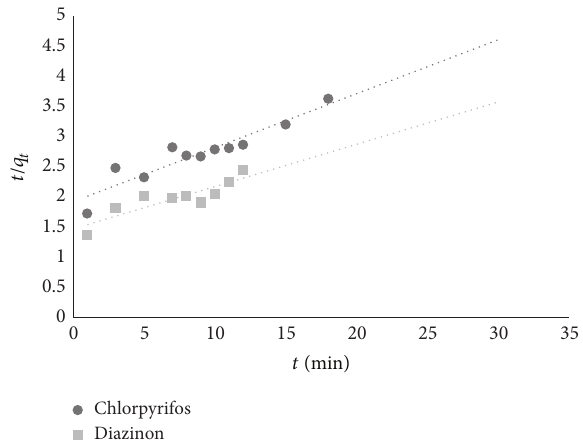
Figure 6: Pseudo second-order kinetic model for adsorption of diazinon and chlorpyrifos by